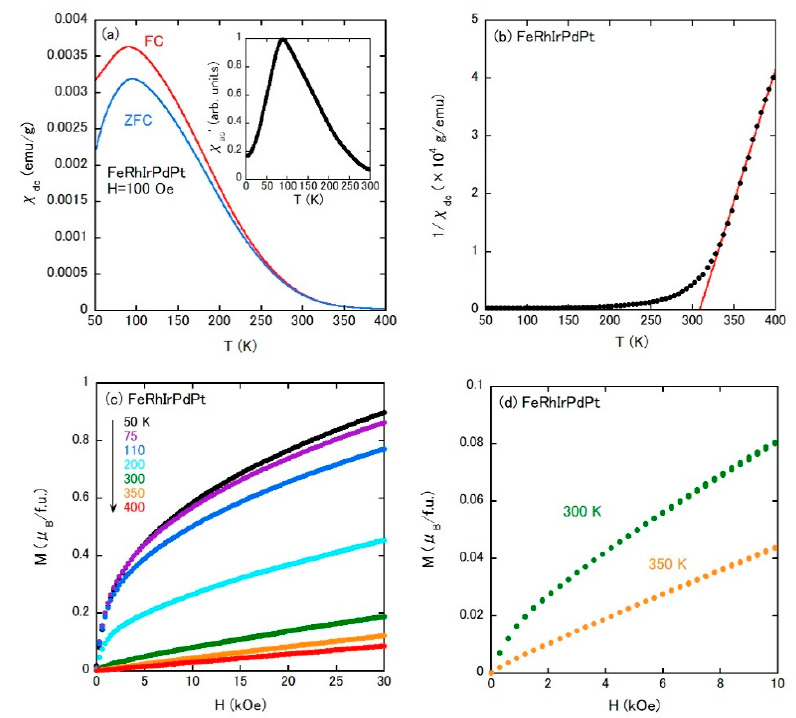
Figure 5. ( a ) Temperature dependence of χ dc measured under ZFC and FC conditions for FeRhIrPdPt. The external field is 100 Oe. The inset is the temperature dependence of the real part of the ac suscep- tibility χ ac (cid:48) ( T ) of FeRhIrPdPt under an ac field of 5 Oe at 800 Hz. ( b ) Temperature dependence of 1/ χ dc measured under FC condition for FeRhIrPdPt. Isothermal magnetization curves of FeRhIrPdPt at 50, 75, 110, 200, 300, 350, and 400 K for ( c ) and at 300 K and 350 K with expanded scale for ( d